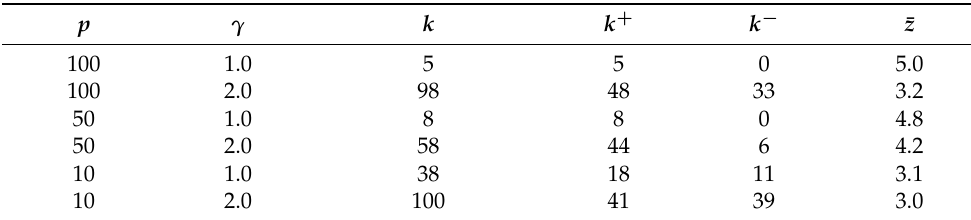
Table 7. Evaluation of topics produced from G p ( D BBC ) with resolution parameters γ = 1.0 and γ = 2.0 at three different values of the reduction percentage p . The table shows for each case the number k of topics produced. The numbers k + and k − indicate how many topics the evaluators found easy to interpret (score 5 or 4) and hard to interpret (score 1 or 2), respectively; ¯ z is the mean score of the topics.